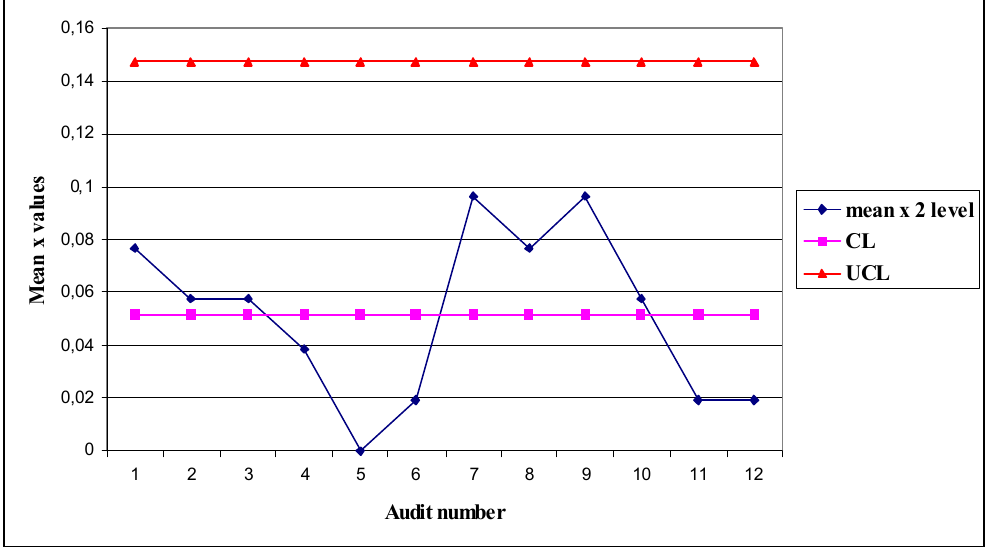
Fig 9. Audit Control Chart for level 2